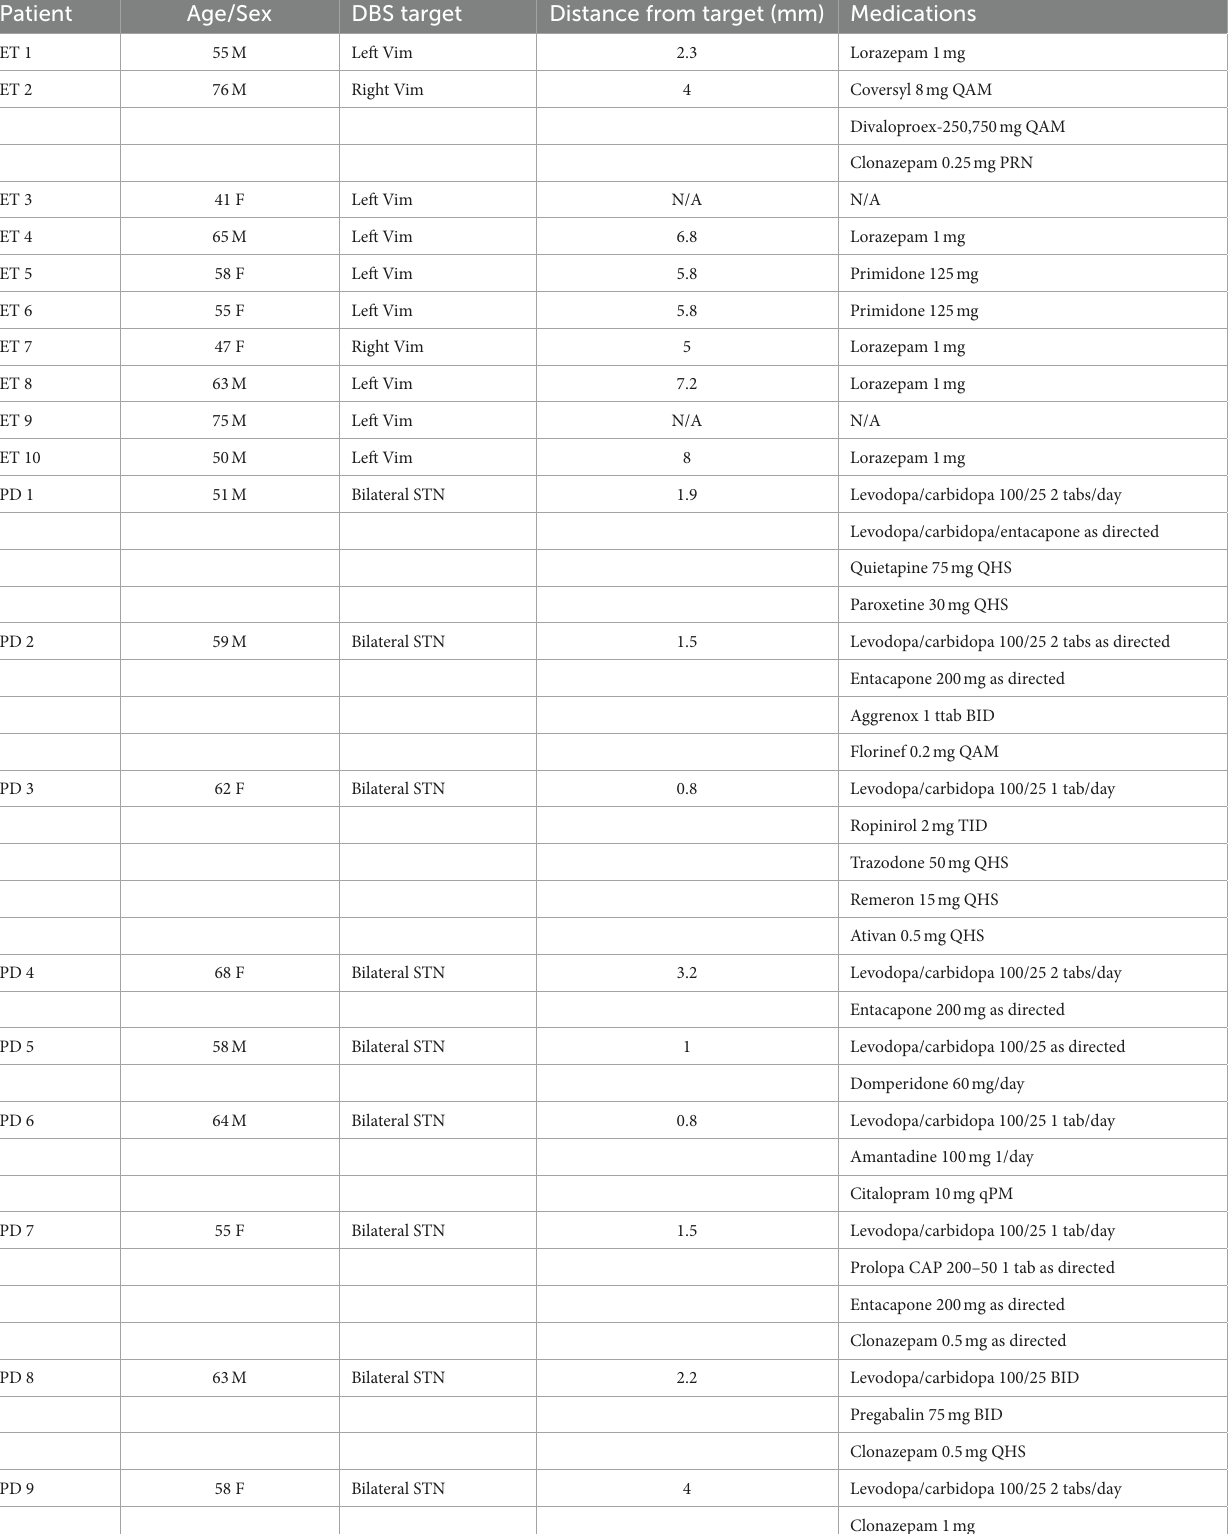
TABLE 1 Demographic and clinical characteristics of